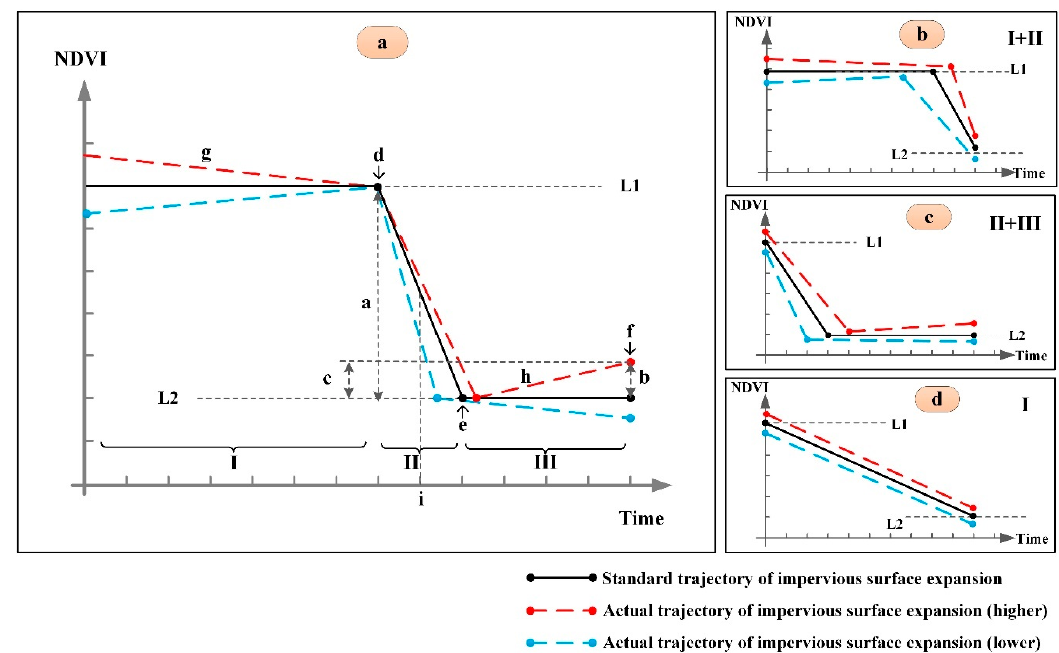
Figure 4. Features of impervious surface expansion trajectories. ( a – d ) represent four types of impervious surface expansion trajectories. I, II, and III represent three phases of impervious surface expansion. NDVI, normalized difference vegetation index.